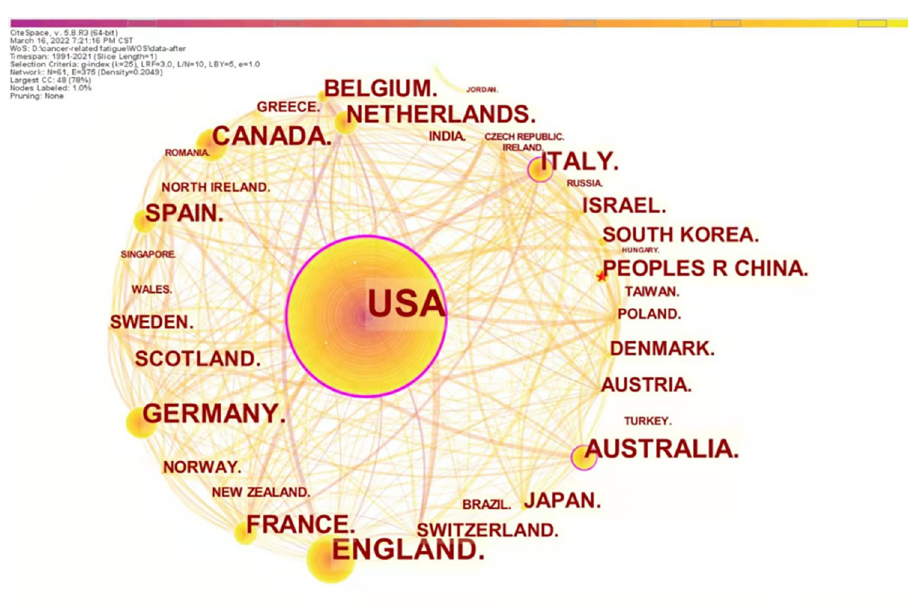
Fig 2. Map of research countries in cancer-related fatigue in ovarian cancer survivors.